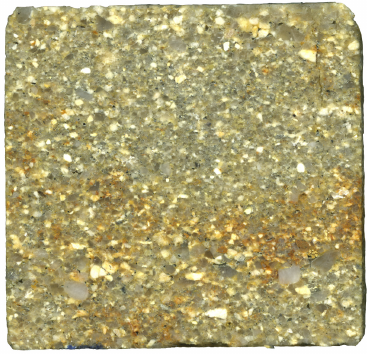
Figure 3. Žehrovice sandstone sample captured using high-resolution flatbed